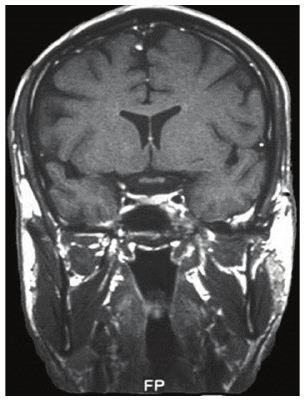
Figure 4: Cranial MRI 16 months after